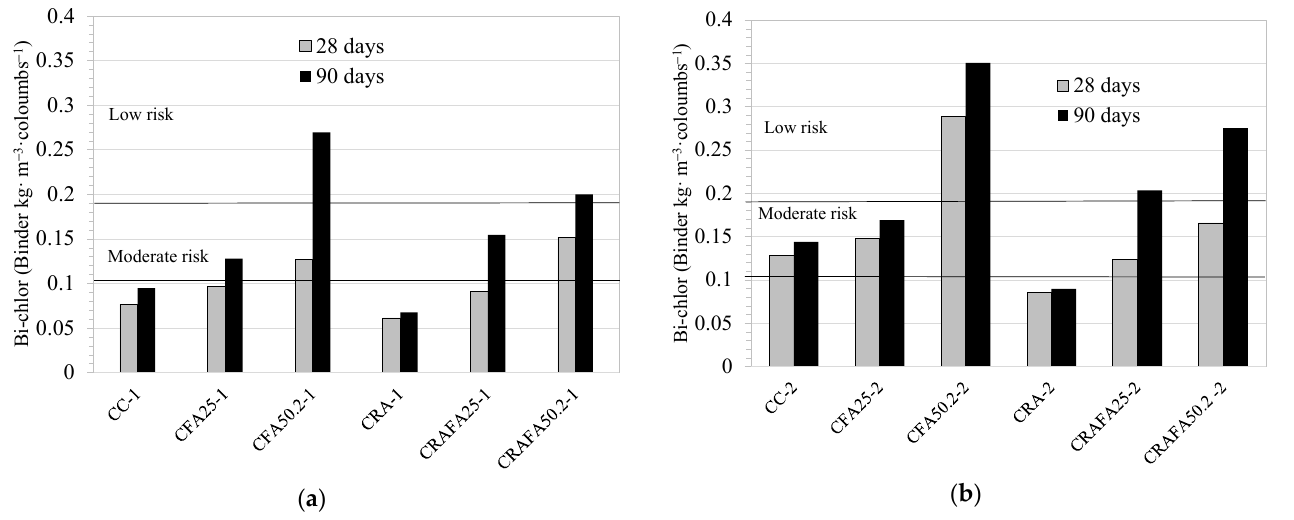
Figure 12. Bi-chlor values for the ( a ) Series 1 and ( b ) Series 2 concretes.